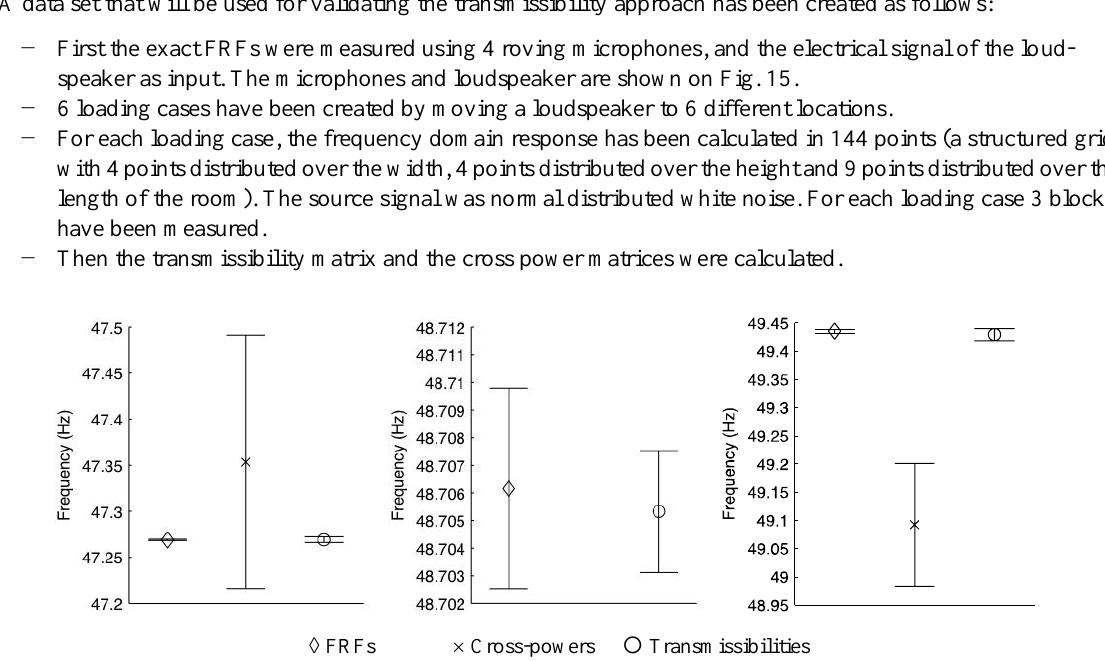
Fig. 14. Results of cluster analysis: damped resonance frequencies.